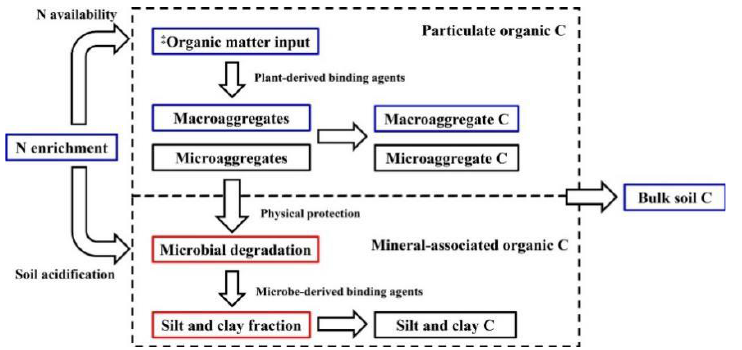
Figure 2. Conceptual model of the dynamic responses of soil aggregates to N enrichment and the potential mechanisms involved in soil aggregation and C sequestration. The blue, red, and black boxes indicate variables that are positively, negatively, or not changed by N enrichment. Reprinted with permission from Ref. [54]. Copyright 2021 Wiley.